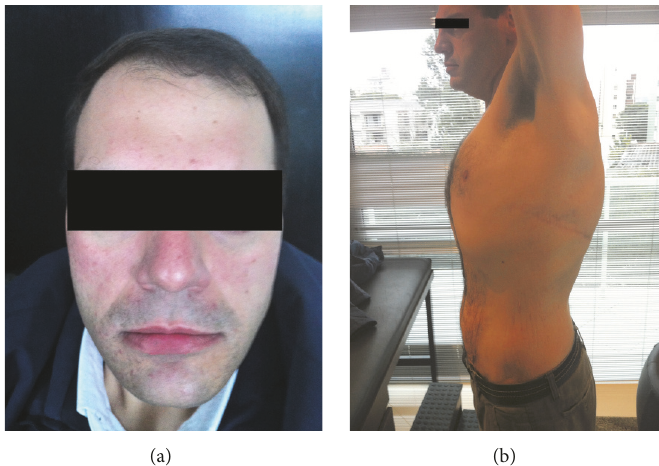
Figure 1: (a) Patient’s face showing broad forehead, high hair implantation, and light hypertelorism; (b) Pectus carinatum .